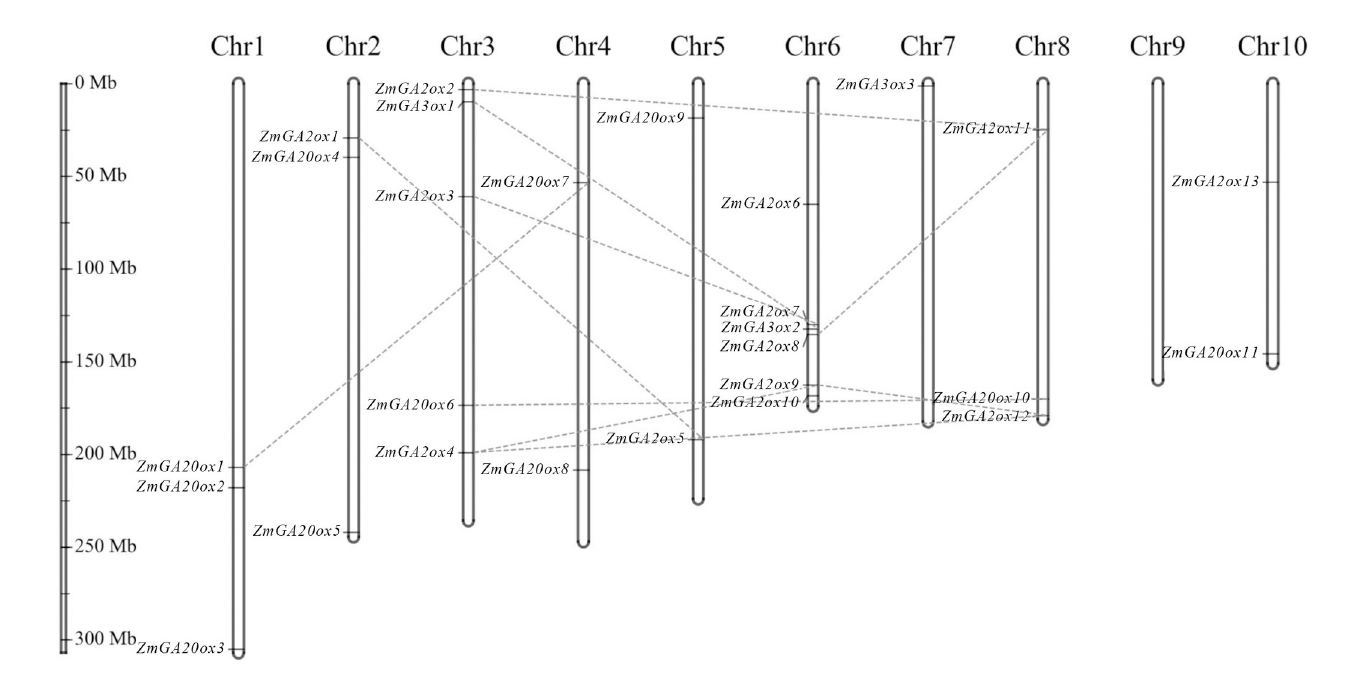
Fig 2. Chromosome distribution for gibberellin-dioxygenases genes in maize. The chromosome distribution was finished by MapGen2Chrom web V2(http://mg2c. iask.in/mg2c_v2.0/).